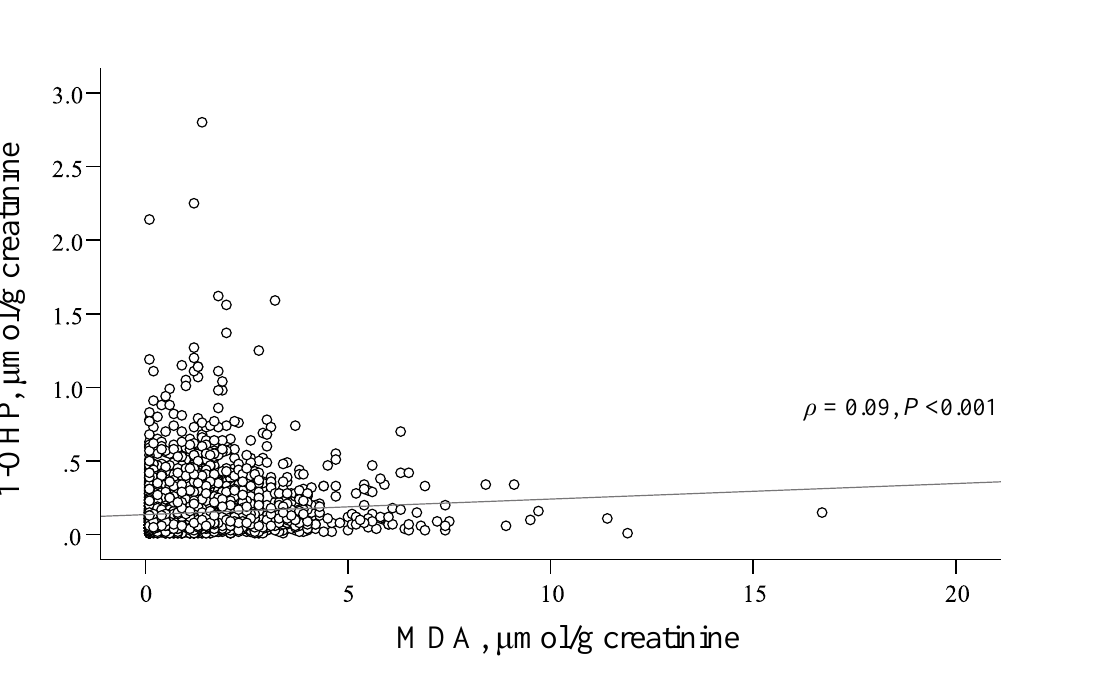
Figure 1. Relationship between MDA and 1-OHP levels. MDA, malondialdehyde; 1-OHP, 1-hydroxypyrene.